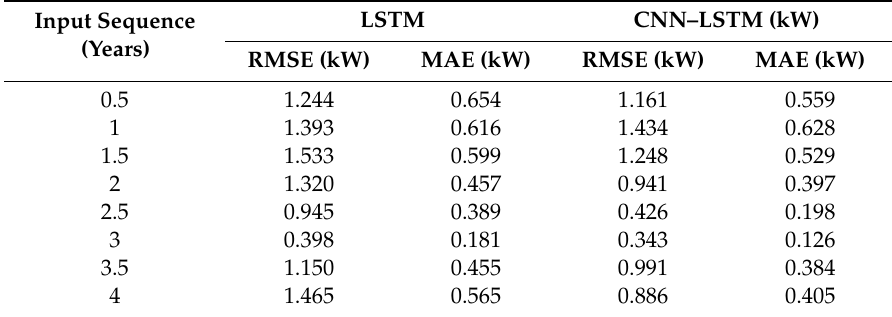
Table 5. Root-mean-square error evaluation metric (RMSE) of LSTM vs. CNN–LSTM based on the input sequence.